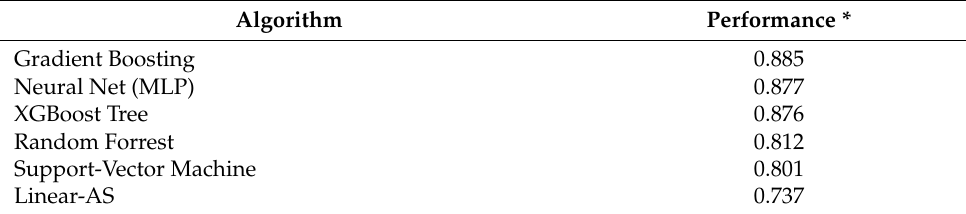
Table 5. Machine learning algorithms’ performance.